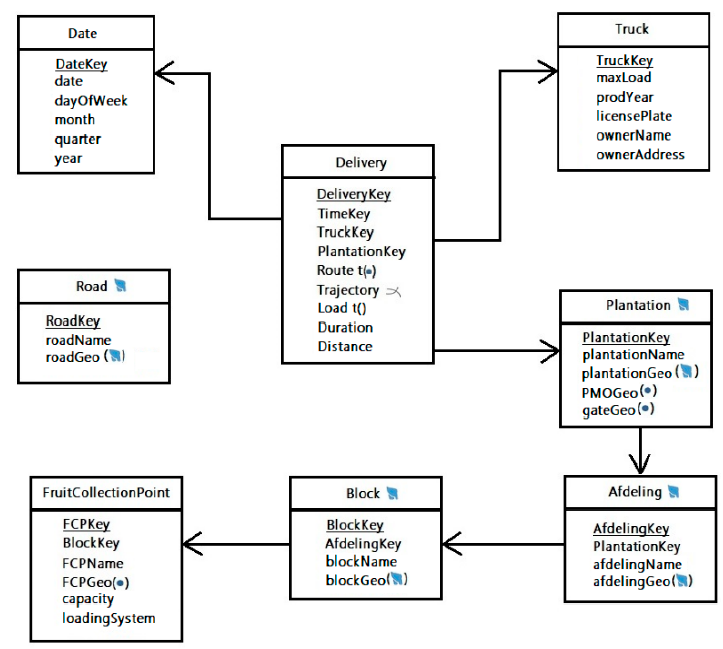
Figure 5. The logical model of the FFB Data Warehouse.